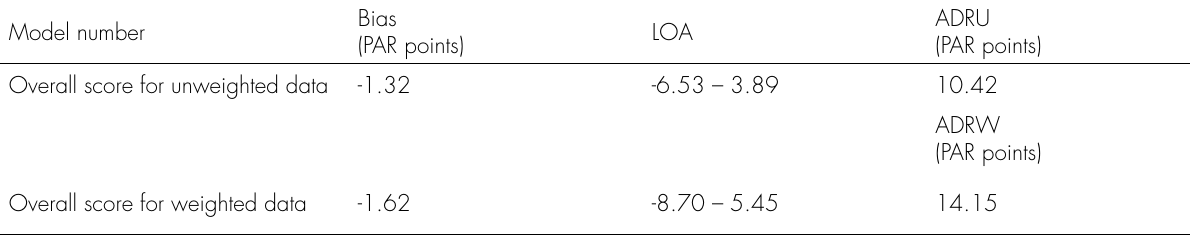
Table I. Unweighted and weighted PAR score Bias and Limits of Agreement (LOA).